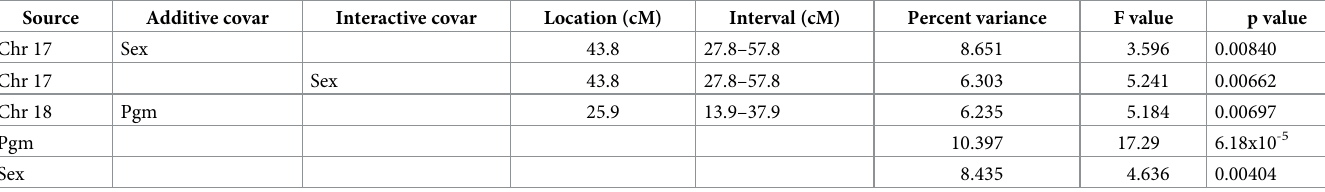
Table 3. Multiple regression model for the survival phenotype in G59S-hDCTN1 mice. Source Additive